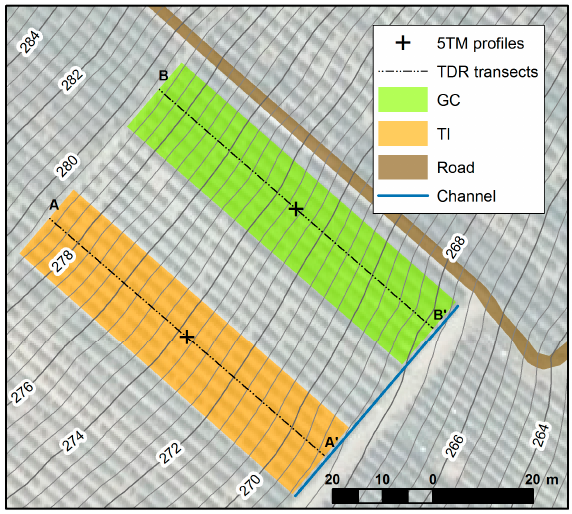
Figure 6. Carpeneto site. Plot of the experimental field. Grass Cover (GC) and Conventional Tillage (TI) represent the two investigated cultivation techniques. The two dotted lines A–A’ and B–B’ represent the investigated TDR transects.